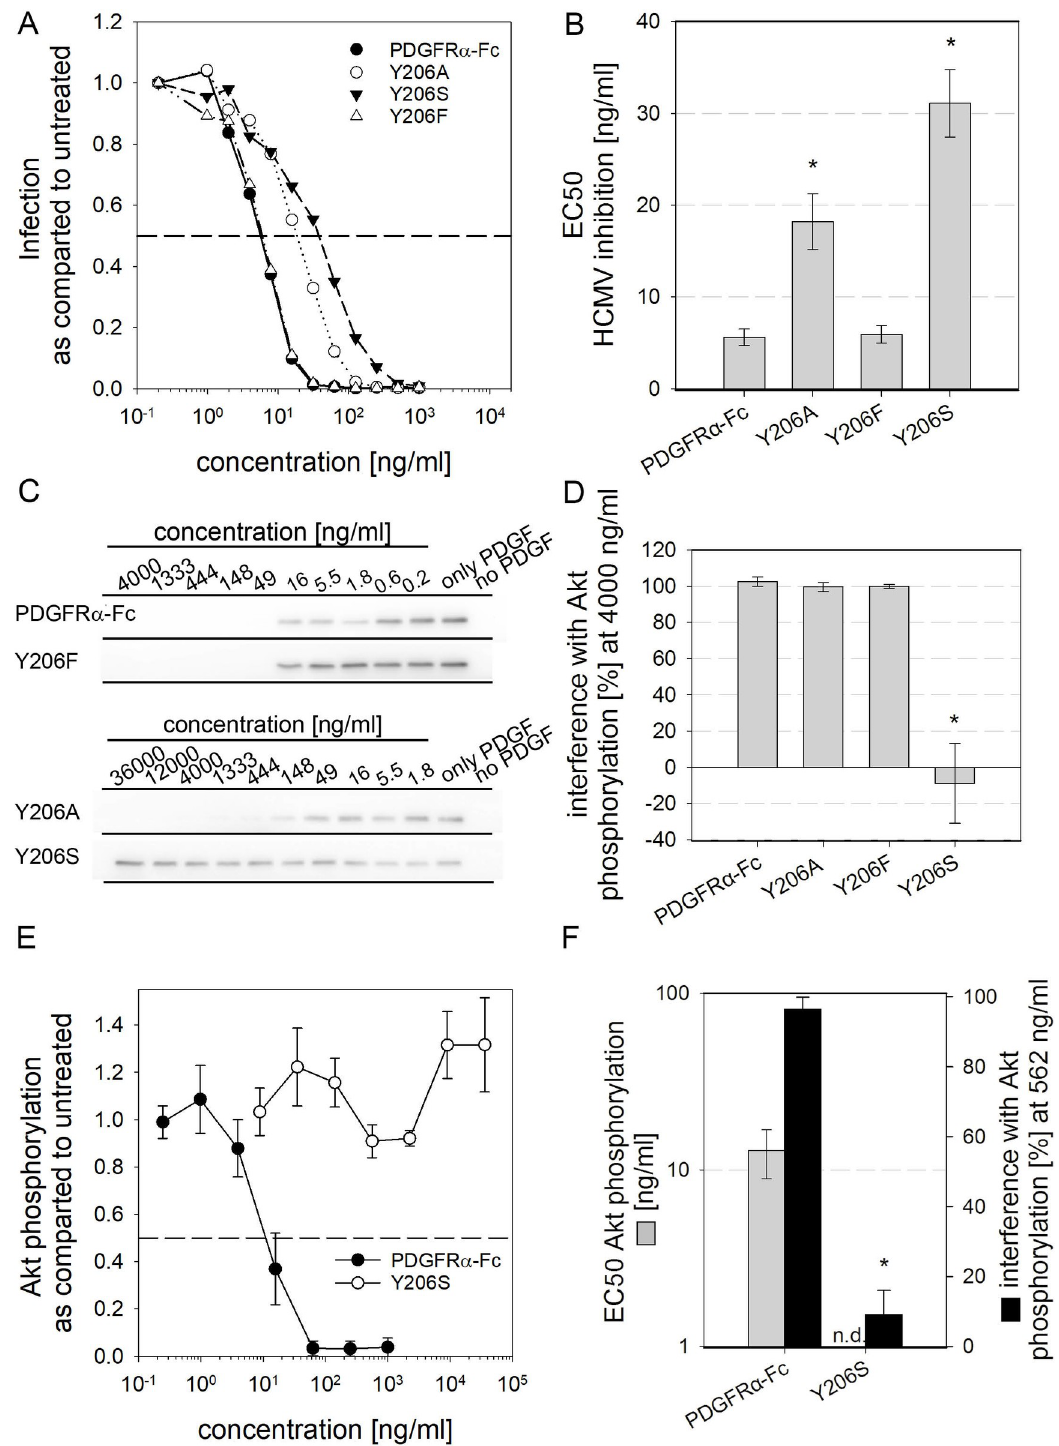
Fig 5. Replacement of tyrosine 206 with serine abolishes PDGF sequestration while maintaining HCMV inhibition. A + B: HCMV at an MOI � 1 was pretreated with various concentrations of PDGFR α -Fc fusion proteins before infection of fibroblasts. Shown is the number of cells expressing the viral immediate early antigens relative to a virus only condition. Dose-response curves, as shown averaged in A , were used as a basis to calculate the half-maximal effective concentrations ( B ) in 3 independent experiments. C to F: Biological interference with PDGF-dependent signaling was tested by preincubation of 6ng/ml PDGF-BB with